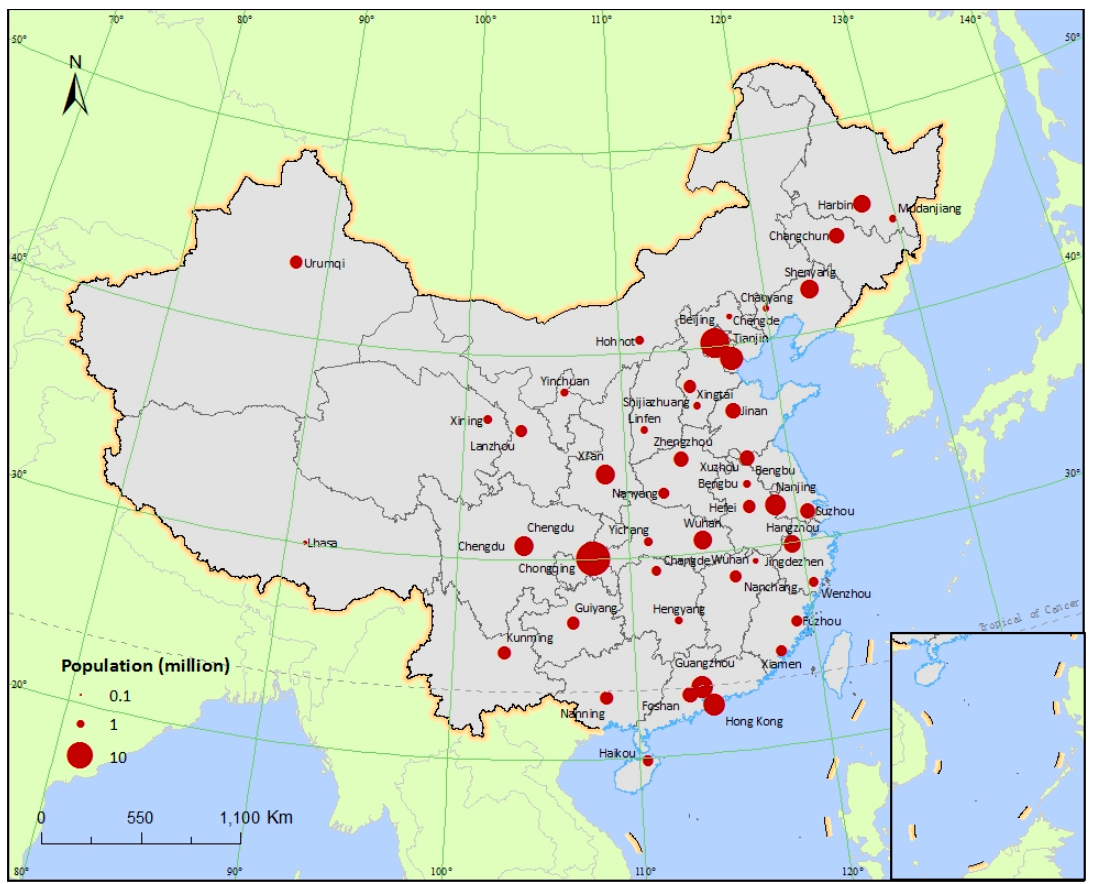
Figure 2. The 45 reference cities selected for developing and validating the proposed method with their urban population in 2013 [54].